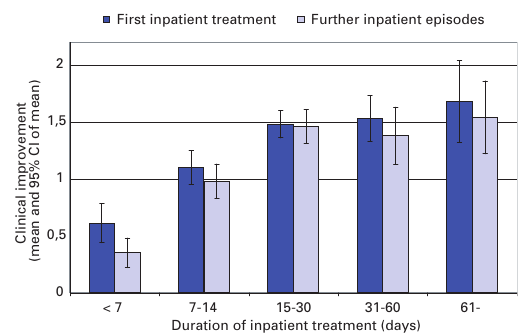
Figure 2 Improvement of clinical symptoms during first and fur- ther inpatient